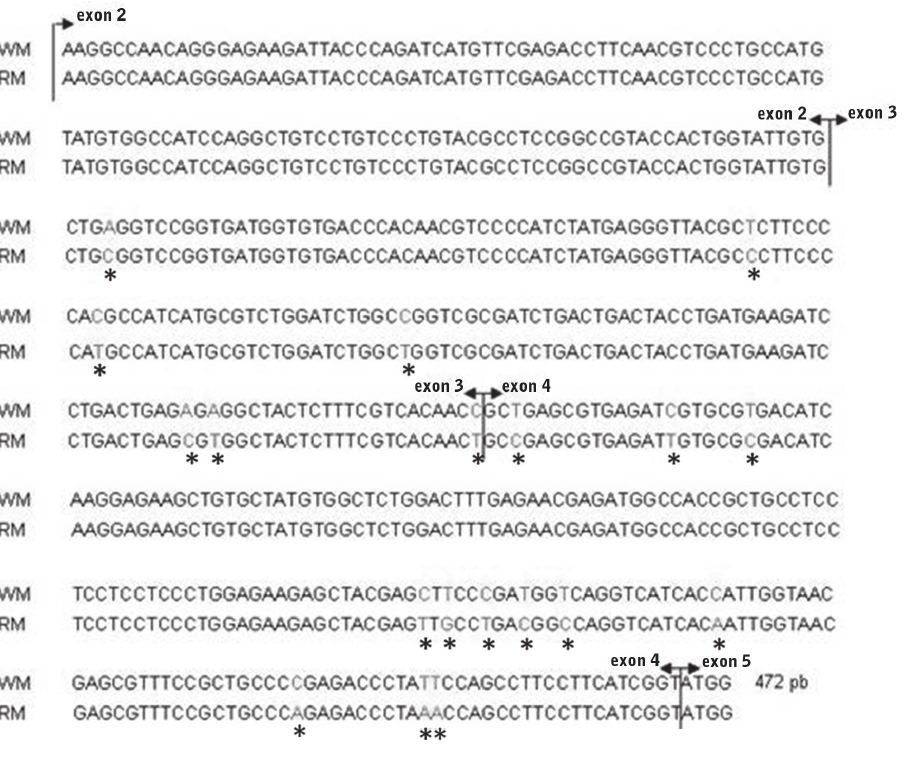
Figure 1 - Consensus nucleotide sequences of partial α-skeletal muscle actin genes isolated from white muscle (WM) and red muscle (RM) of Leporinus macrocephalus . Asterisks indicate nucleotide variations. Regions of beginning and ending of the exons are indicated by